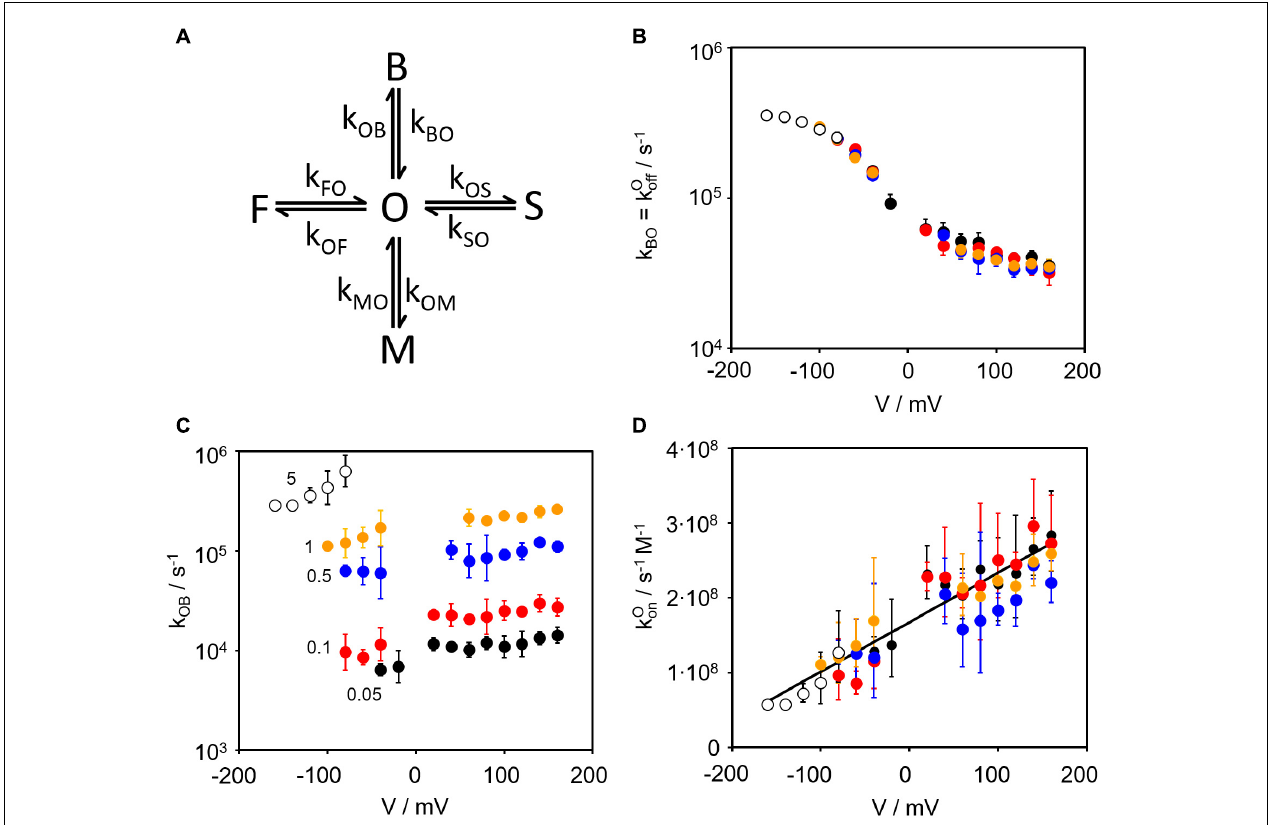
FIGURE 2 | Kinetics of the TPrA block. (A) Kinetic Markov model used for the fits of the amplitude histograms ( Supplementary Figure S1 ). The states O (open) and F, M, S (three closed states of different dwell times) are those used previously in the 4-state model of gating in the unblocked Kcv NTS (Rauh et al., 2017a, 2018). The blocked state B is introduced by the blocker TPrA. (B) Voltage dependence of the rate constant k BO = k O off measured at cytosolic TPrA concentrations of 0.05 mM , 0.1 mM , 0.5 mM , 1 mM , and 5 mM . (C) Voltage dependence of k OB = k O on [ TPrA ] measured at the same concentrations as k BO , (D) Voltage dependence of k O on as determined by dividing k OB by the concentration of TPrA in mol. Data points are the geometric mean of 3 to 4 individual channels, error bars represent the geometric standard deviation. Some data points around 0 mV are missing because of insufficient signal-to-noise